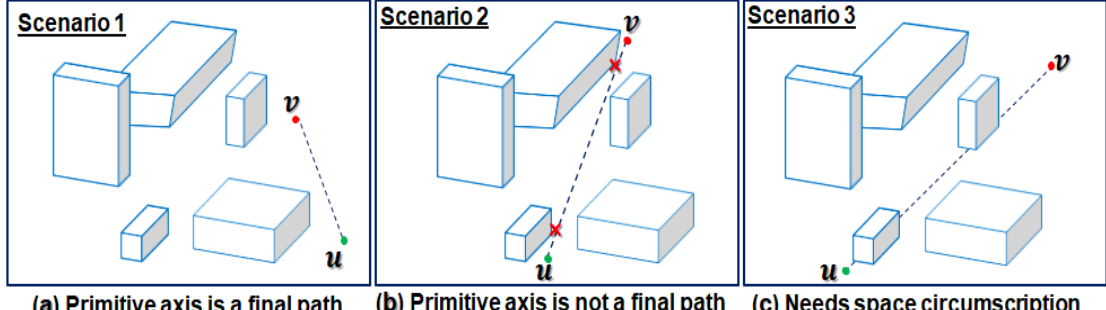
Figure 3. Results of primitive axis between source and target locations.